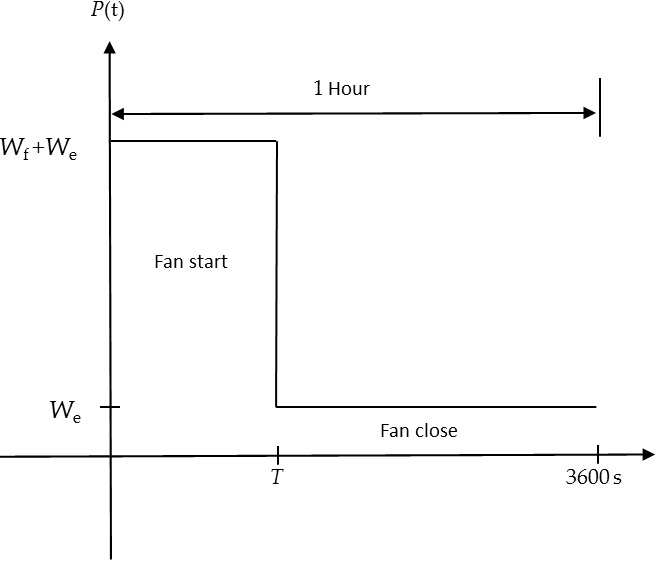
Figure 10. Hourly power consumption curve.